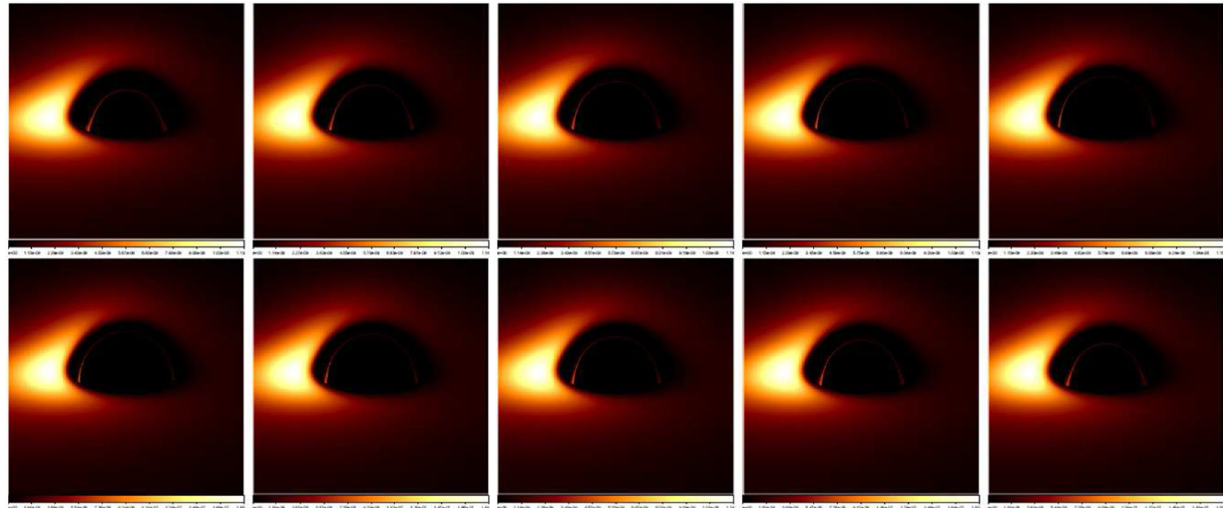
the PPL and the bottle row is for the PPM. In each row, the coupling parameter α from left to right is taken to − 0 . 4, − 0 . 2, 0, 0 . 2 and 0 . 4, respectively. Here, we set M = 1